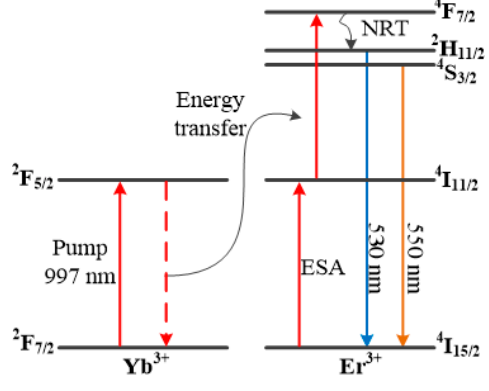
Figure 10. Energy level diagram of Er 3+ and Yb 3+ ions.